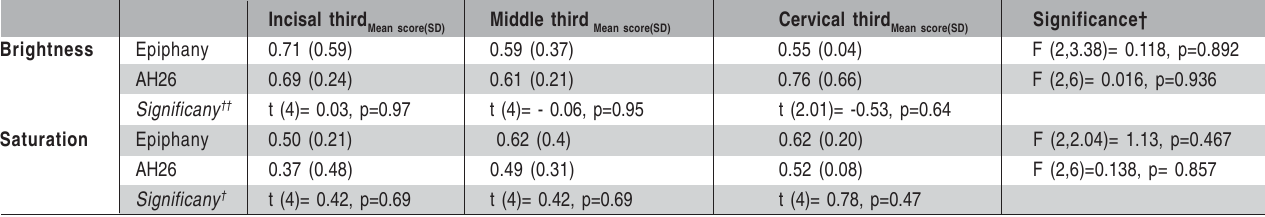
† Statistically Significany calculated by one-way ANOVA †† Statistically significant segmental difference between two groups calculated by t-test.